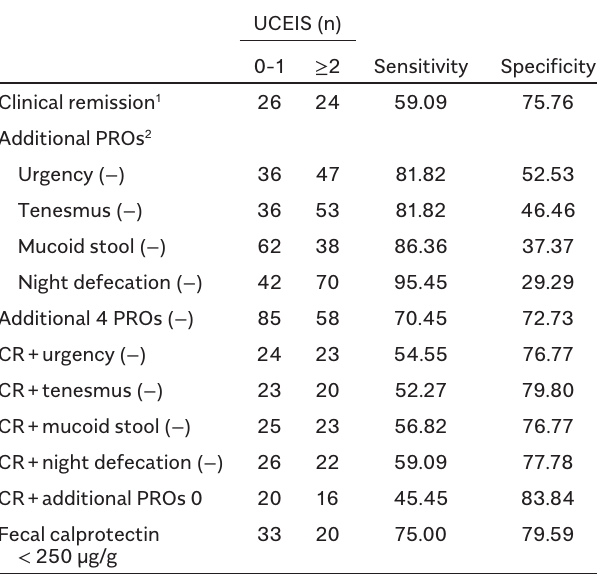
Table 2. Basic and Additional Patient-Reported Outcomes of the Patients with Mucosal Healing Defined as Ulcerative Colitis Endoscopic Index for Severity (UCEIS) 0-1